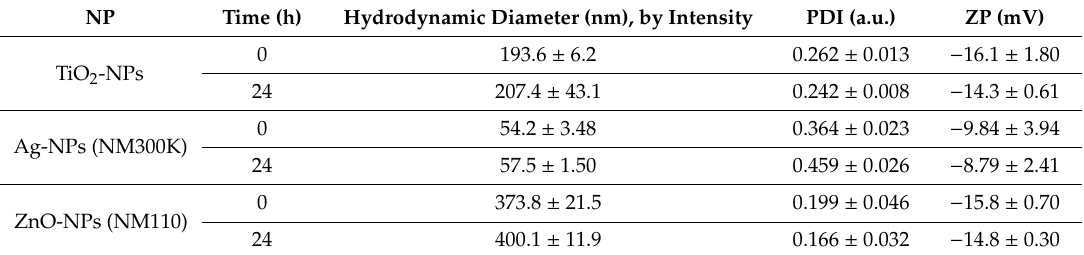
Table 2. Hydrodynamic diameter and zeta potential (ZP) of nanoparticle (NP) stock dispersions (concentrations: TiO 2 455 µ g / mL; Ag and ZnO 2.56 mg / mL). For analysis, samples were diluted 1:10 in pure water. Numbers are given as mean ± standard deviation (SD) ( n = 3). PDI: polydispersity index,